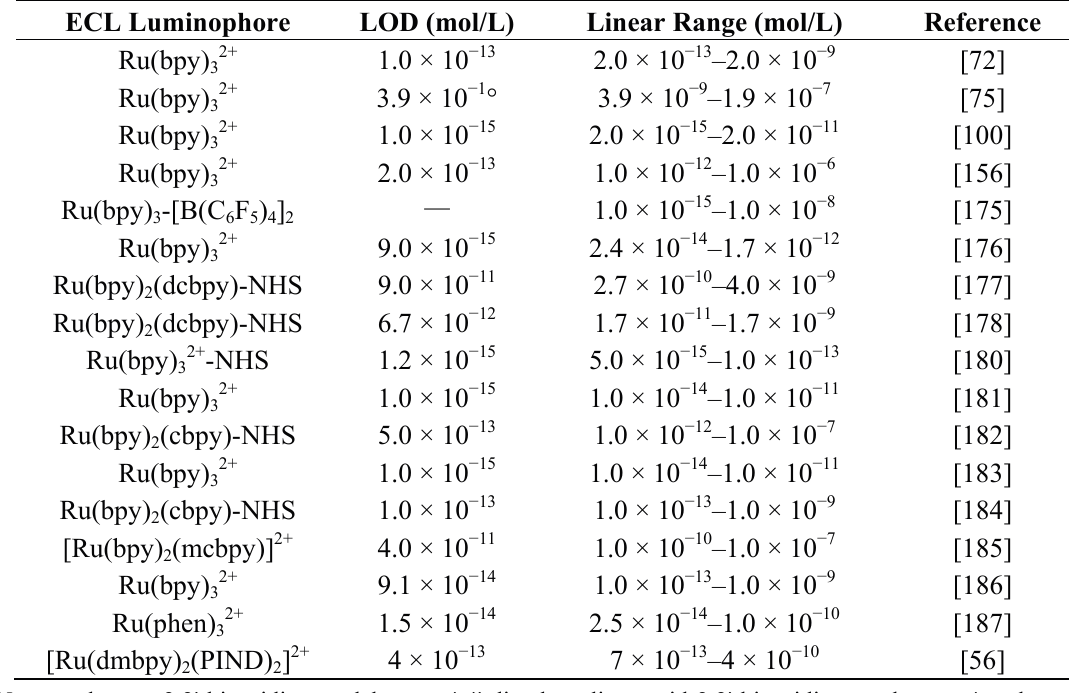
Table 1. DNA detection using ECL method with ruthenium